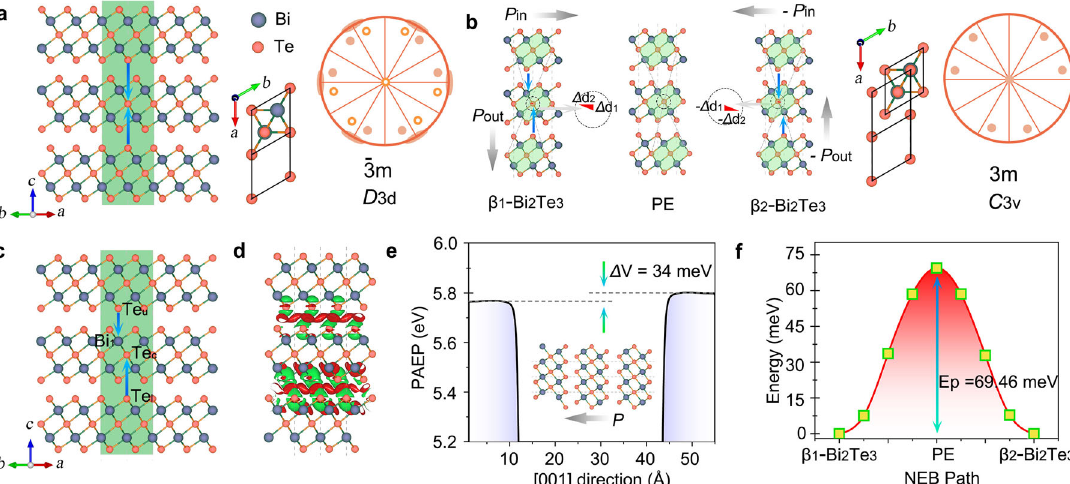
Fig. 2 Structural con fi gurations and ferroelectricity. Crystal structures of trilayer Bi 2 Te 3 with ( a ) inversion symmetry and c broken inversion symmetry. Te u and Te l represent the bottom Te sublattice of upmost Bi 2 Te 3 QL and top Te sublattice of lowest Bi 2 Te 3 QL, respectively; Te u denotes the middle Te sublattice of central Bi 2 Te 3 QL. b Crystal structures of β 1 - and β 2 -Bi 2 Te 3 as well as the schematic diagram of ferroelectric switching. Blue arrows denote the location of interfacial Te atoms of outmost layers. Right parts in a , b show the zoomed-in interfacial atomic layers and the equatorial plane projection of point group. d Charge density difference and e planar average electrostatic potentials along the [001] direction for β 1 -Bi 2 Te 3 . f Minimum energy path for ferroelectric polarization reversal between β 1 - and β 2 -Bi 2 Te 3